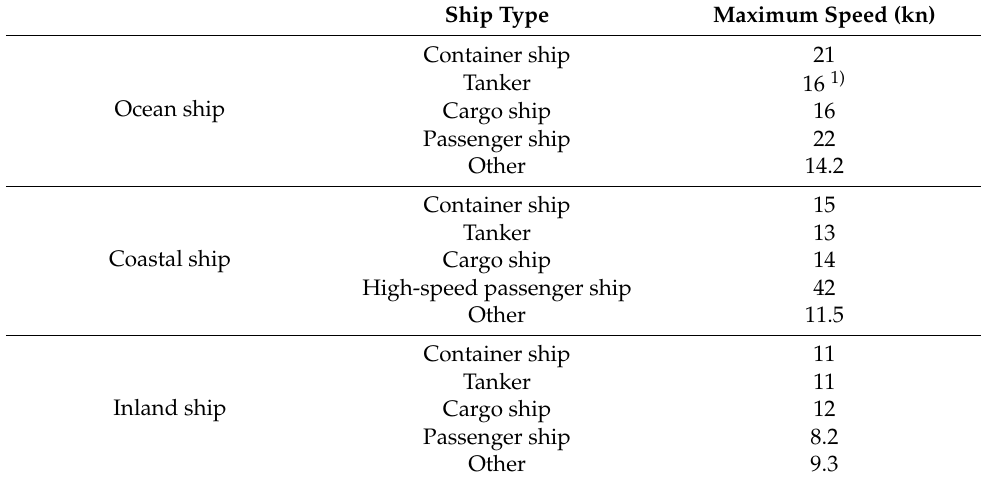
Table 8. Maximum speed of